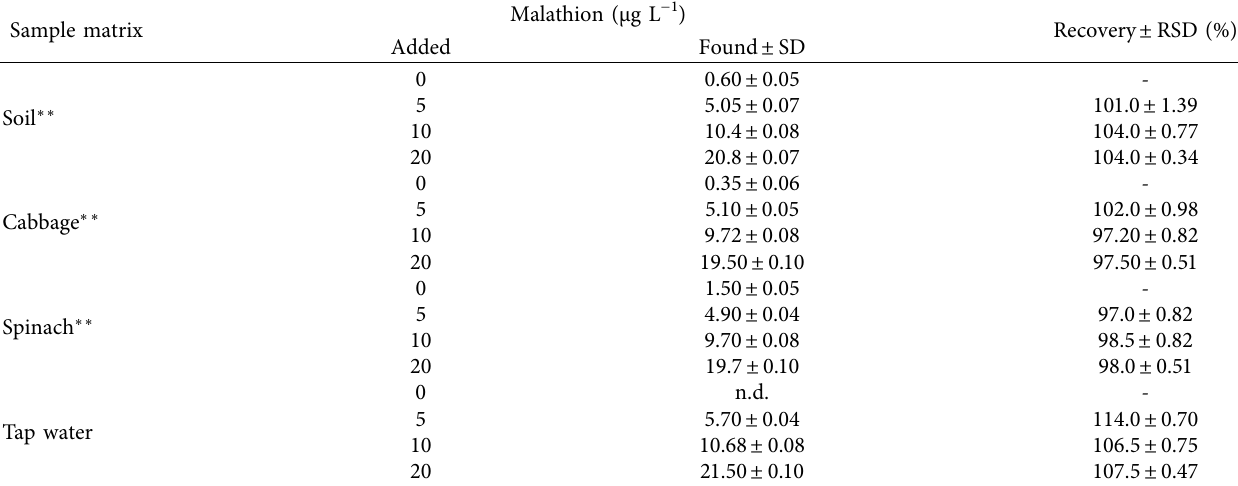
Table 3: Determination of malathion in soil, vegetables (ng g − 1 ), and water (ng mL − 1 ) samples by the developed SW-CSV method ∗ . Sample matrix